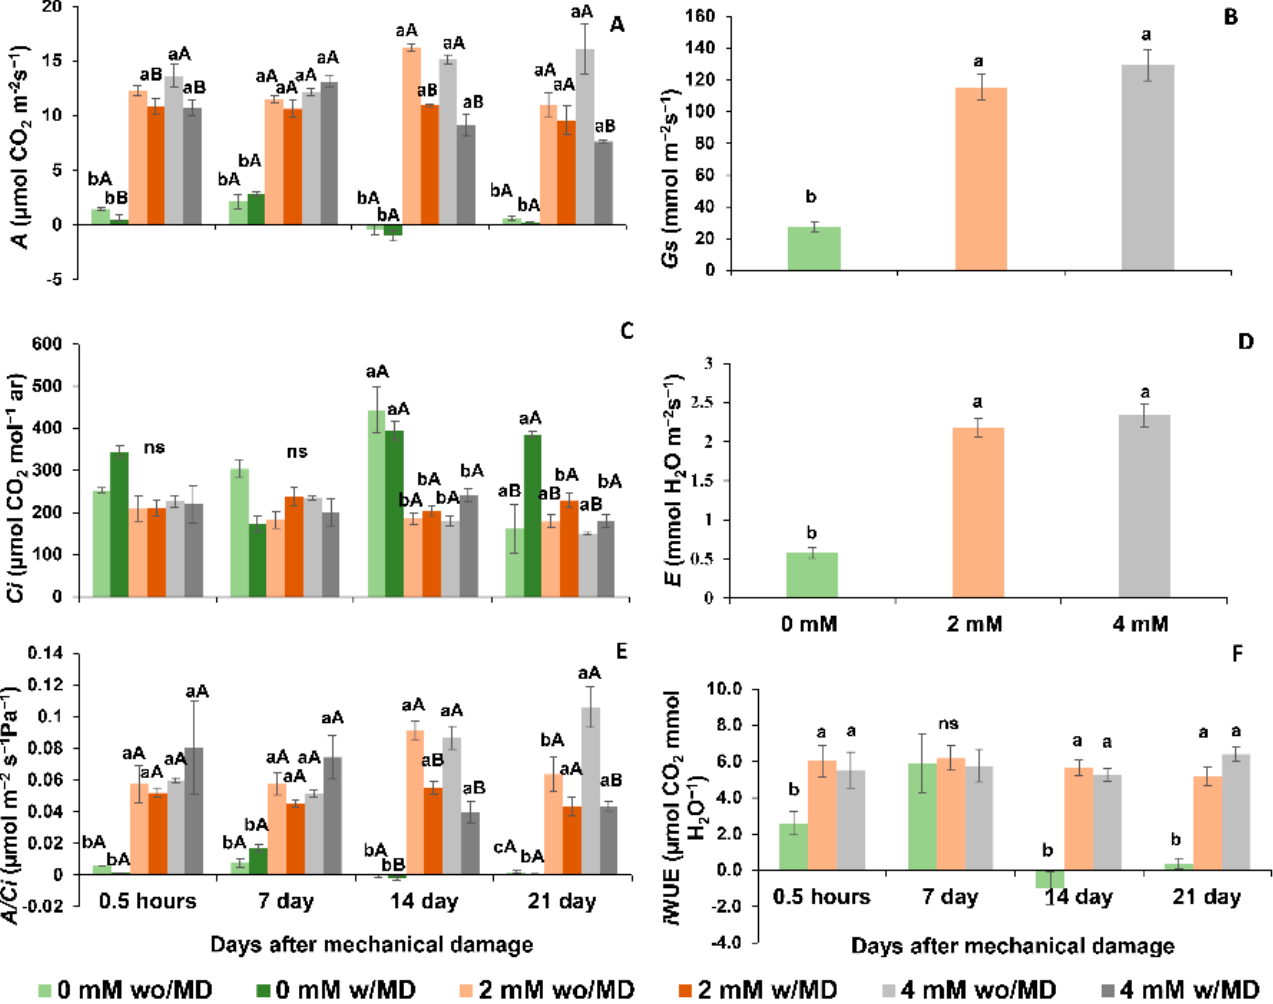
Figure 7. ( A ). CO 2 assimilation rate ( A ) time × damage × calcium p < 0.005; ( B ). stomatal conductance ( Gs ) calcium p < 0.001; ( C ). internal leaf CO 2 concentration ( Ci ) time × damage × calcium p < 0.001; ( D